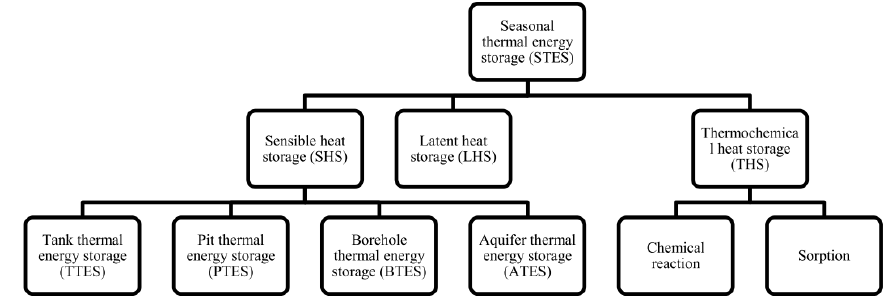
Figure 1. Schematic representation of the nodes of the TES [4].